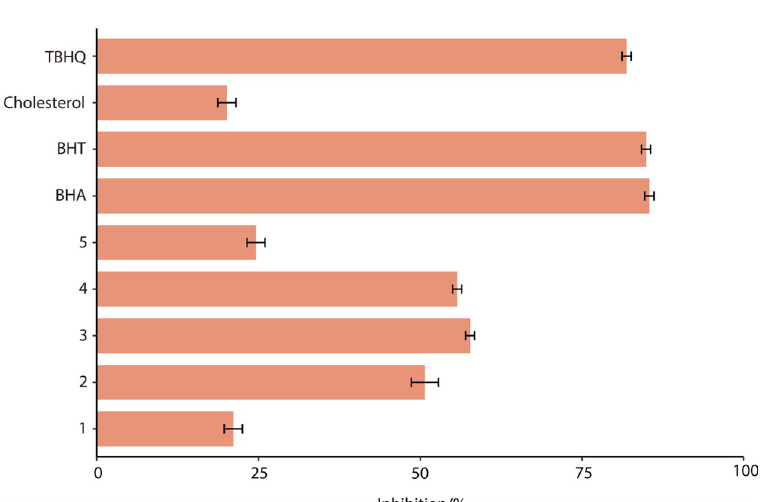
Fig 3. Lipid peroxidation (LPO) inhibitory activities of sterols (1–5) isolated from the hexane extract of L . japonica and commercial cholesterol tested at 25 μ g/mL. Commercial antioxidants BHA, BHT and TBHQ used as positive controls at 1.8, 2.2 and 1.6 μ g/mL. The oxidation of lipid was initiated by the addition of Fe 2+ ions. The varying concentrations of positive controls used were to yield a comparable activity profiles between 50–100% by test compounds and positive controls alike. Vertical bars represent the standard deviation of each data point (n = 2).